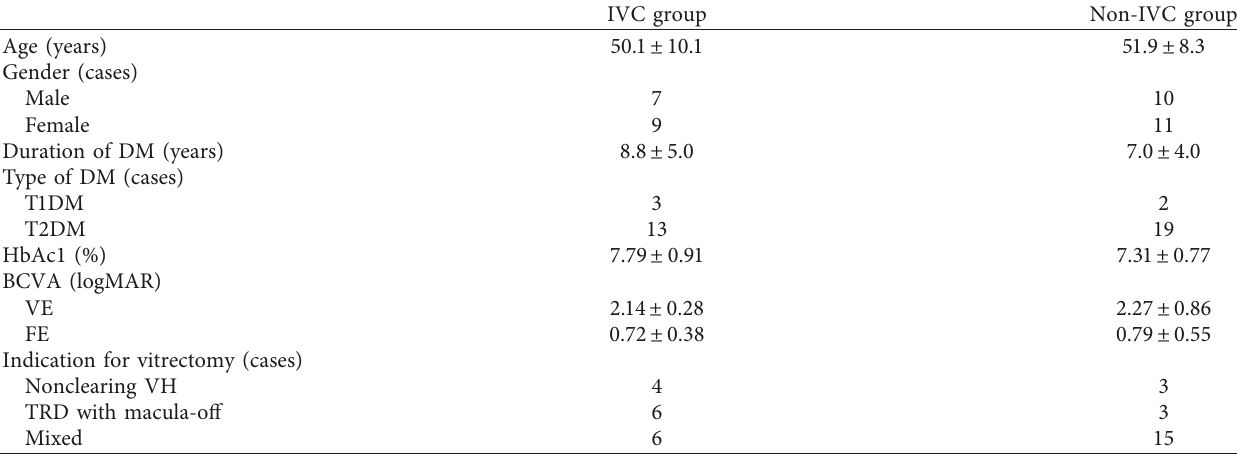
Table 1: Demographic data and preoperative details of patients.